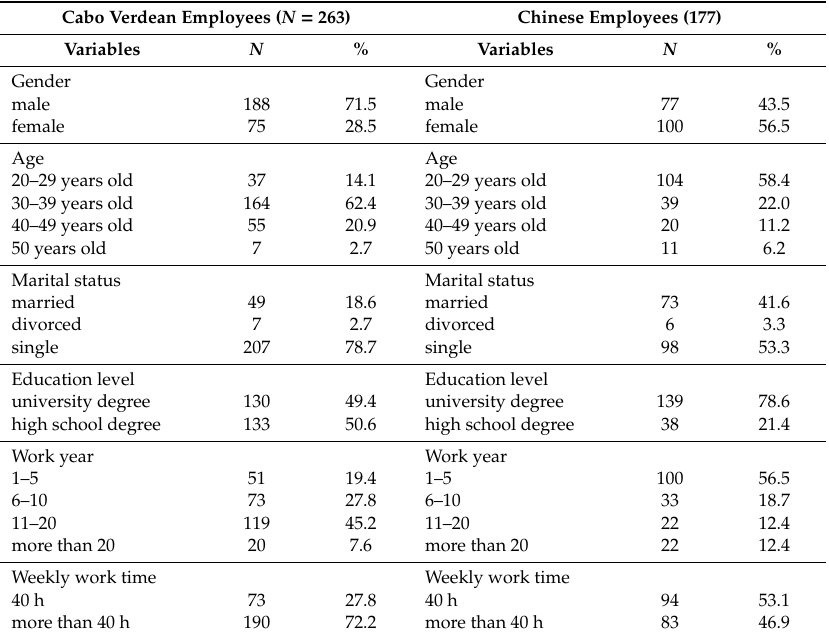
Table 1. Demographic profile of the overall